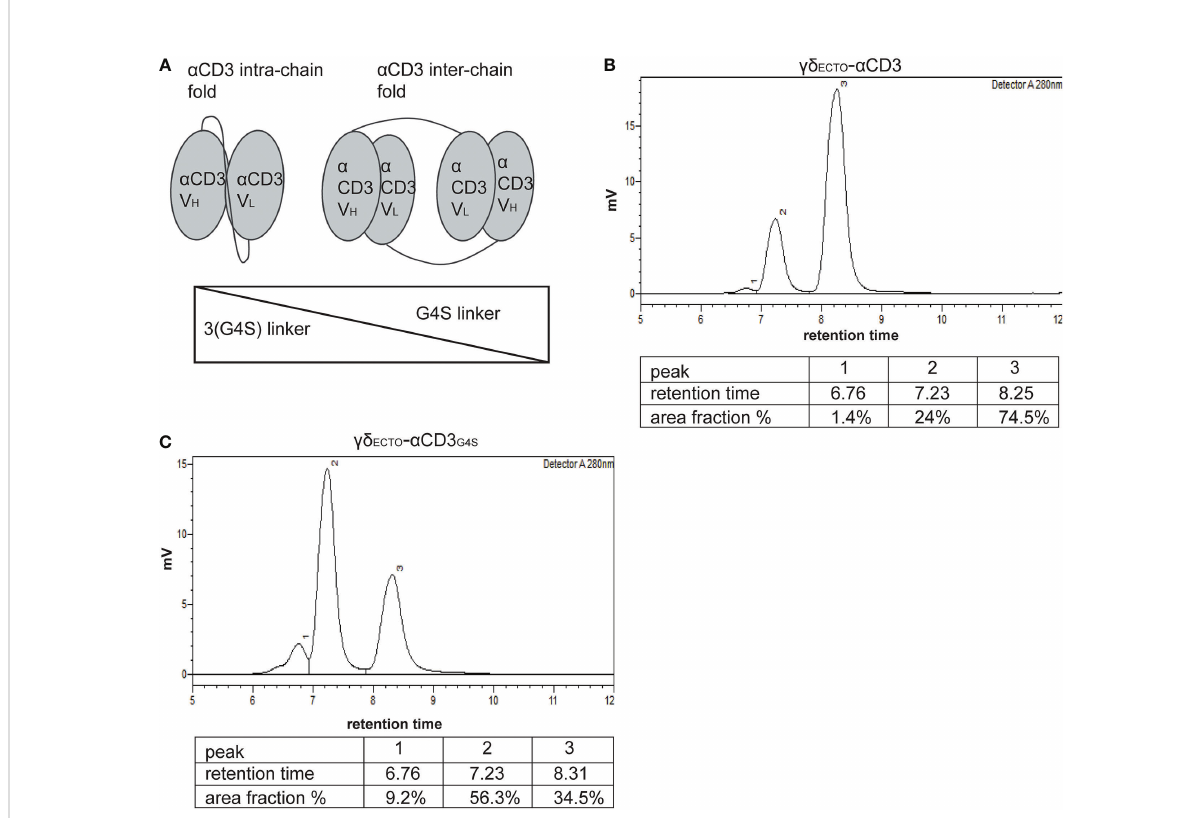
FIGURE 4 gd ecto - a CD3-dimers are formed by a CD3 dimerization, which is in fl uenced by linker length between the heavy and the light chain. (A) Schematic representation of a CD3 either folded by with intra-chain interaction (left) or with inter-chain interaction of two a CD3s (right). B+C) Size exclusion chromatography of gd ecto - a CD3 comprising the linker 3(G4S) (B) or gd ecto - a CD3 G4S (C)